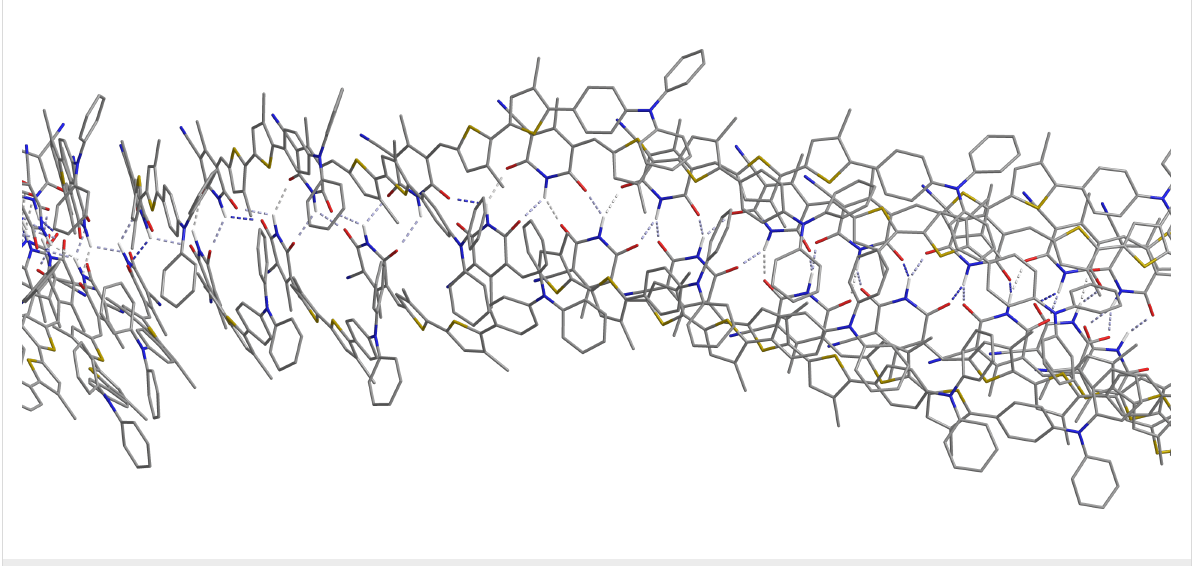
Figure 6: Schematic representation of self-complementary interactions leading to one-dimensional chains.